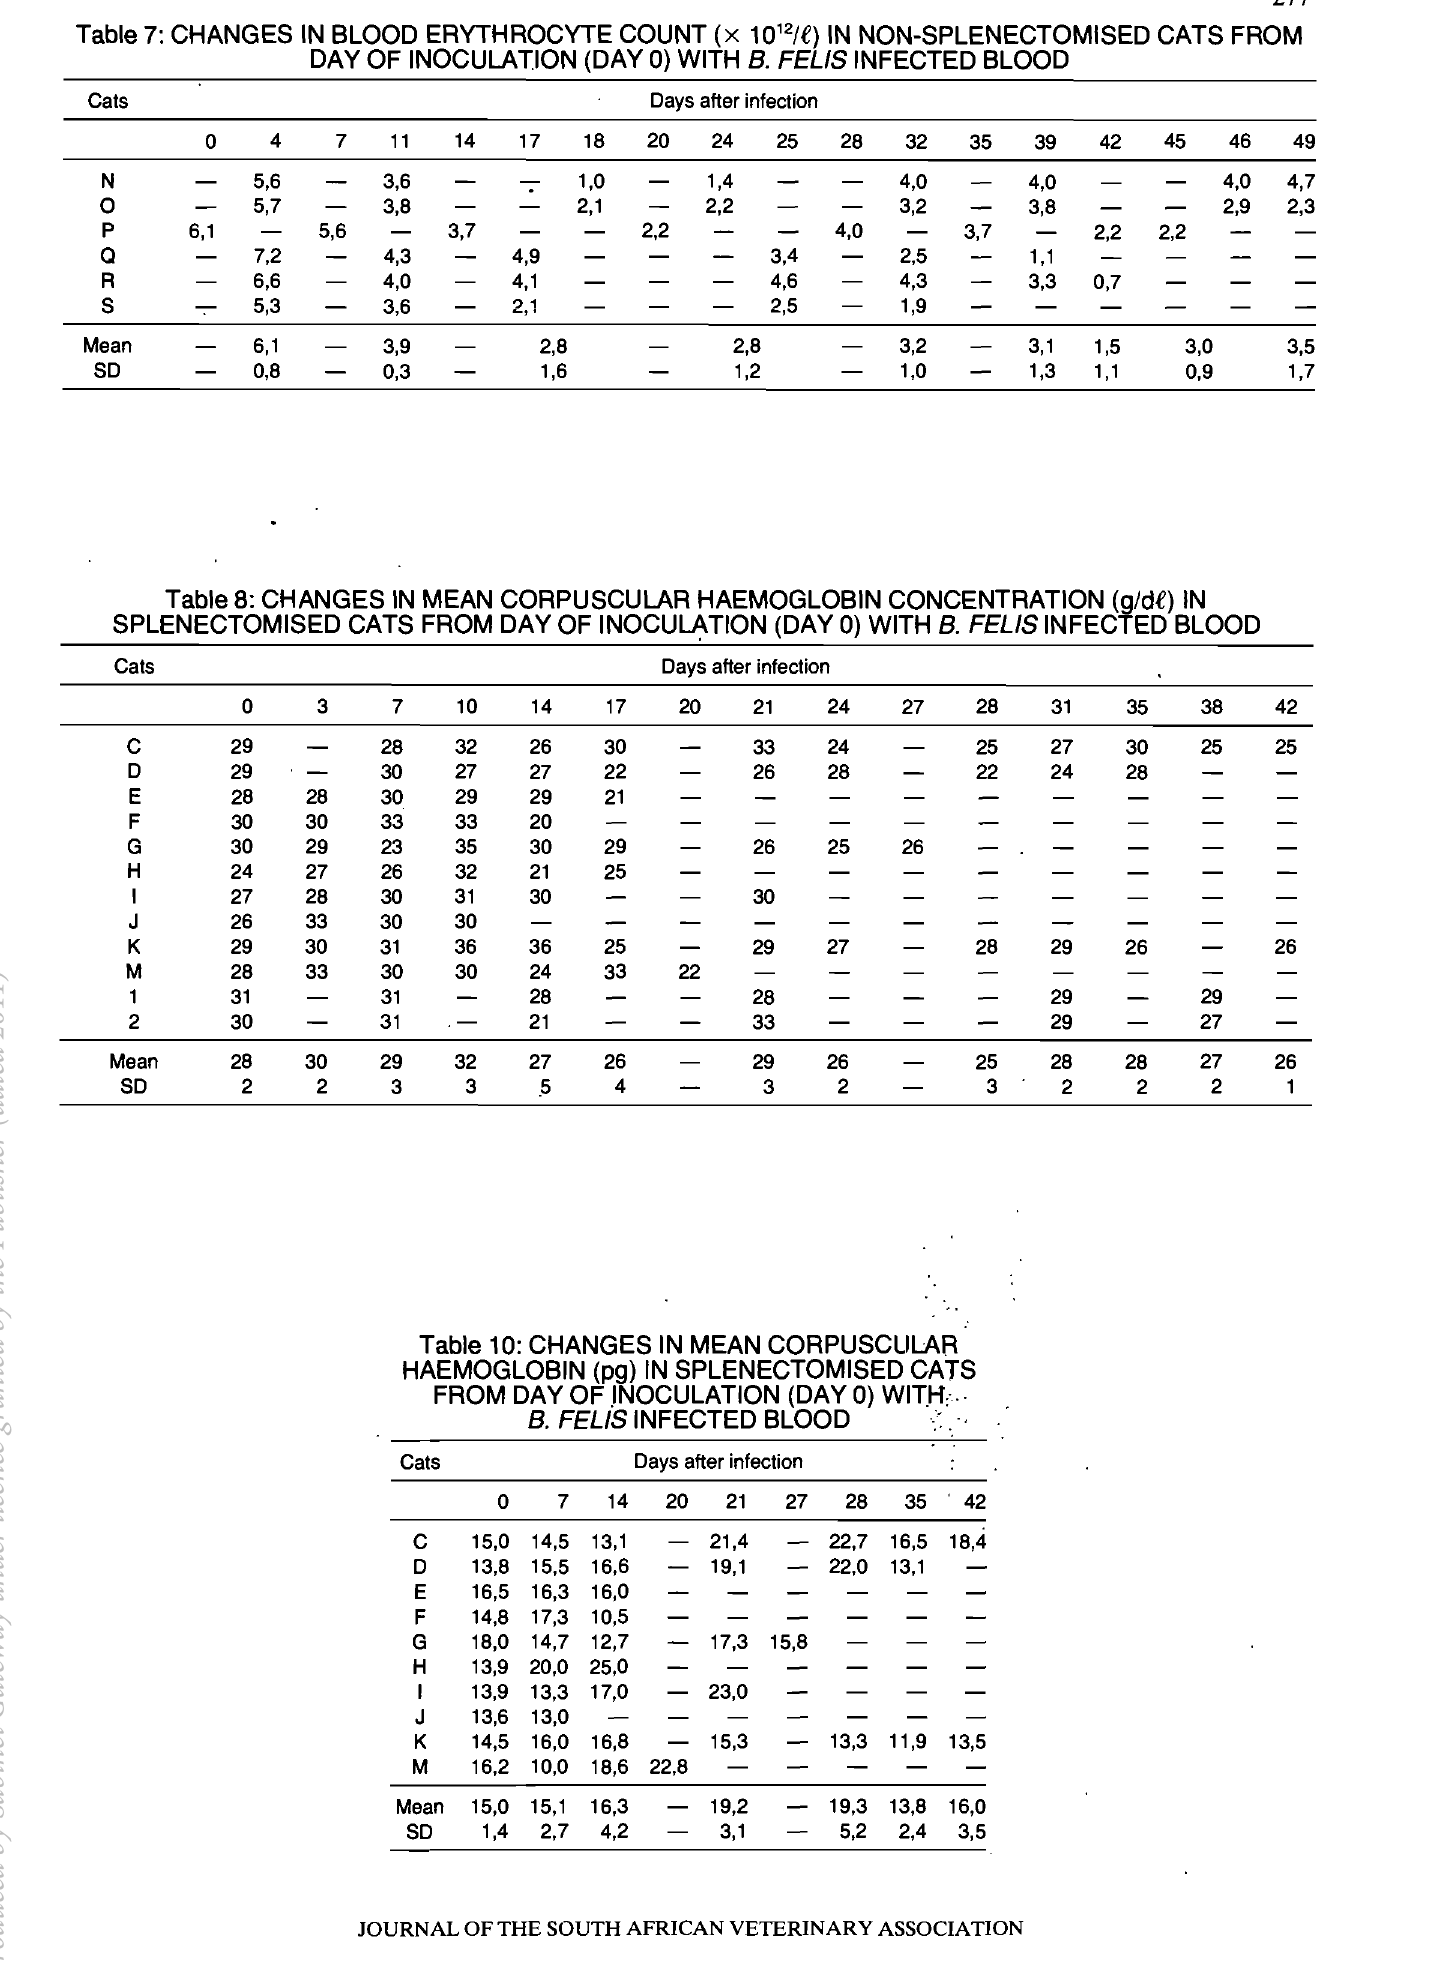
Table 7: CHANGES IN BLOOD ERYTHROCYTE COUNT (x 1012/e) IN NON-SPLENECTOMISED CATS FROM DAY OF INOCULATION (DAY 0) WITH B. FELIS INFECTED BLOOD